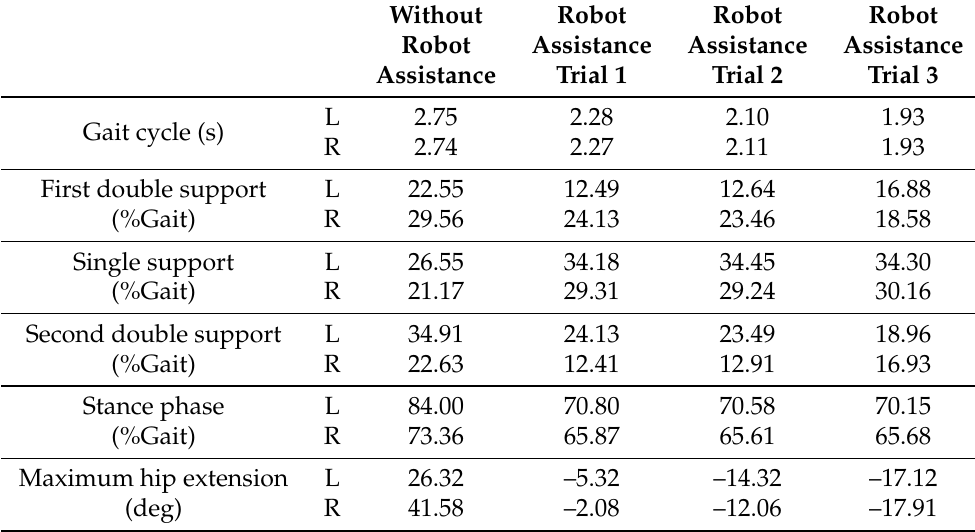
Figure 18. Applied torque profiles of three trials for ( a ) left hip joint, ( b ) right hip joint, ( c ) left knee joint, and ( d ) right knee joint. Only the extension torques of the right knee joint were different in each case. Table 6. Gait analysis results of